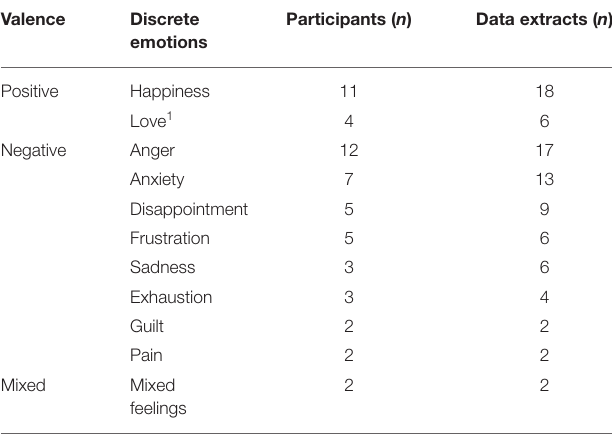
TABLE 3 | The participants’ emotions unfolding in doctoral